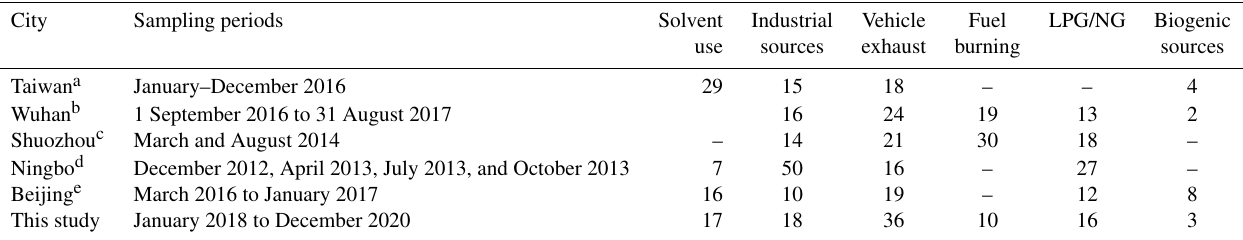
use sources exhaust burning sources